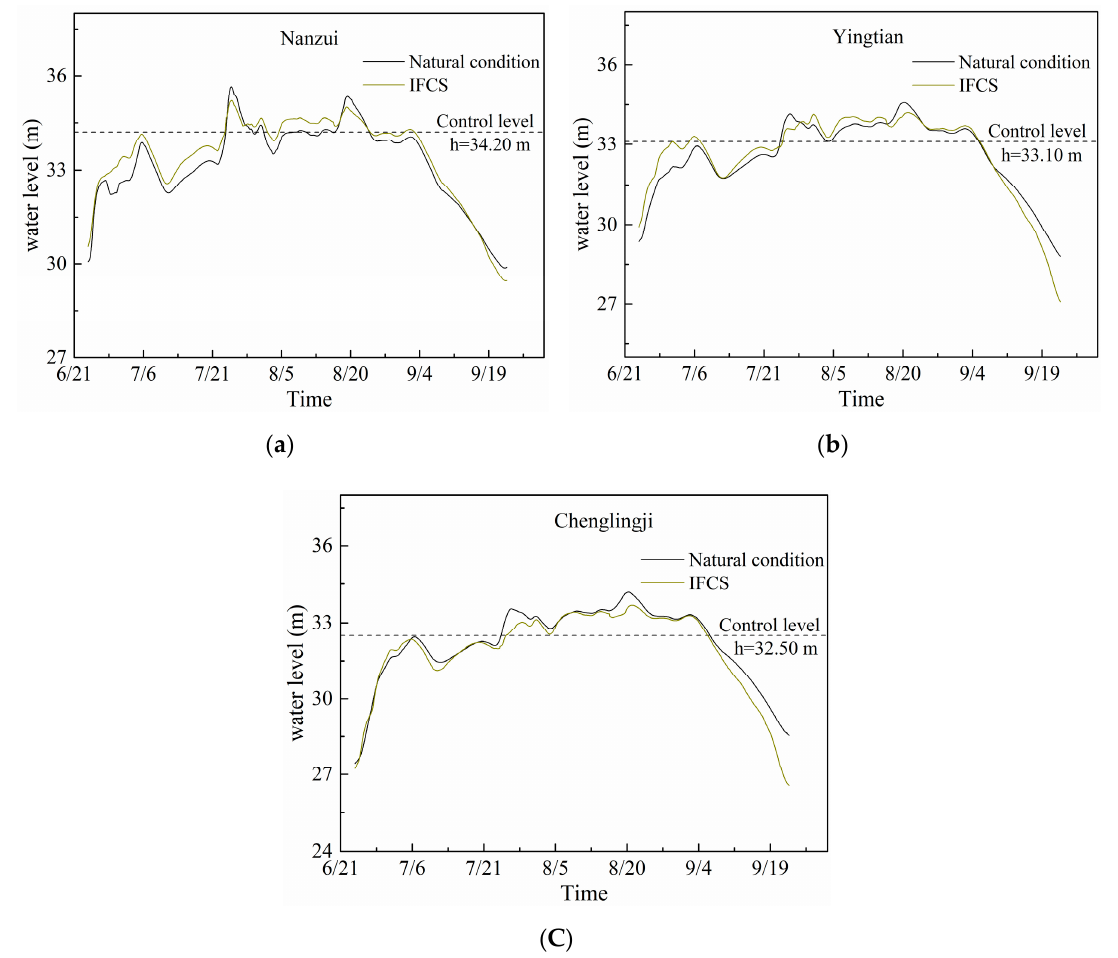
Figure 7. The water level process during the flood season (24 Jun. to 22 Sep. 1998) in Dongting Lake with and without IFCS. ( a ) Nanzui station; ( b ) Yingtian station; and, ( c ) Chenglingji station.